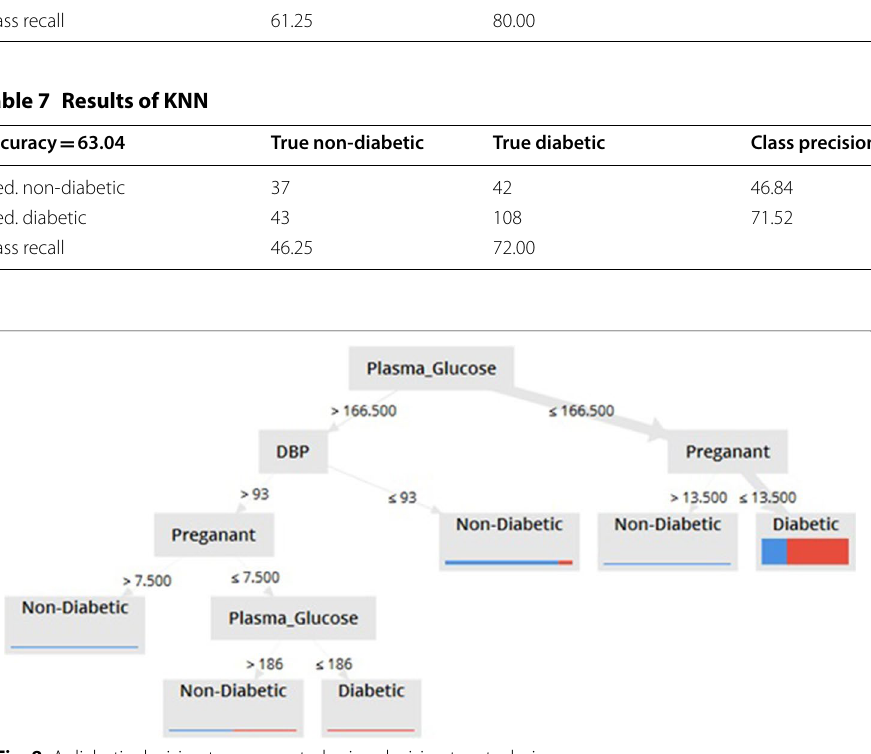
Fig. 8 A diabetic decision tree generated using decision tree technique